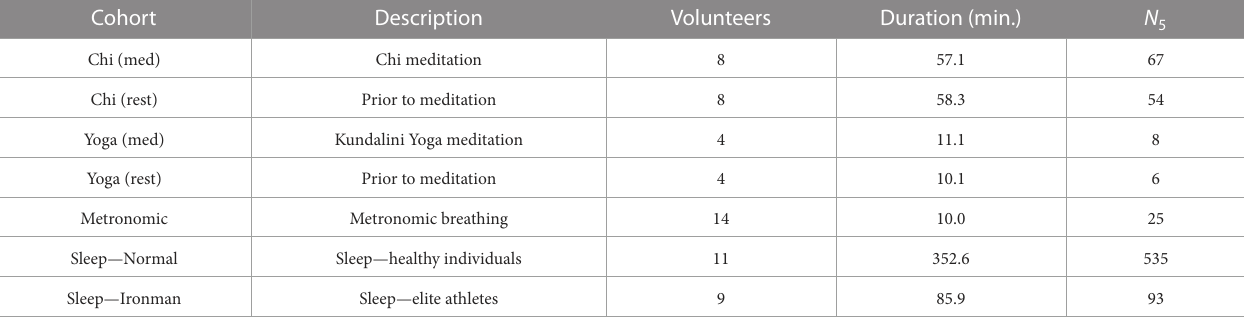
TABLE1 Sevencohortsofvolunteers:Chi(med)andYoga(med)arethetwomeditationcohorts,whileChi(rest)andYoga(rest)arecontrolspriortomeditation. Alsoconsideredarethemetronomicbreathing,normalhealthyadultsduringsleep,andeliteathletesduringsleep.‘Duration’referstotheaveragetimeper volunteer(minutes),and N 5 isthetotalnumberof5-min